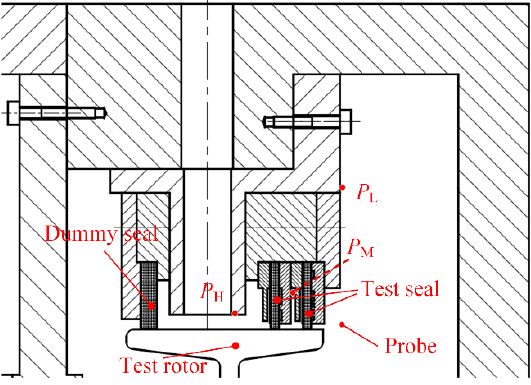
Appl. Sci. 2021 , 11 , 2239 Figure 9. Partial schematic diagram of the test cavity. Figure 9. Partial schematic diagram of the test cavity.